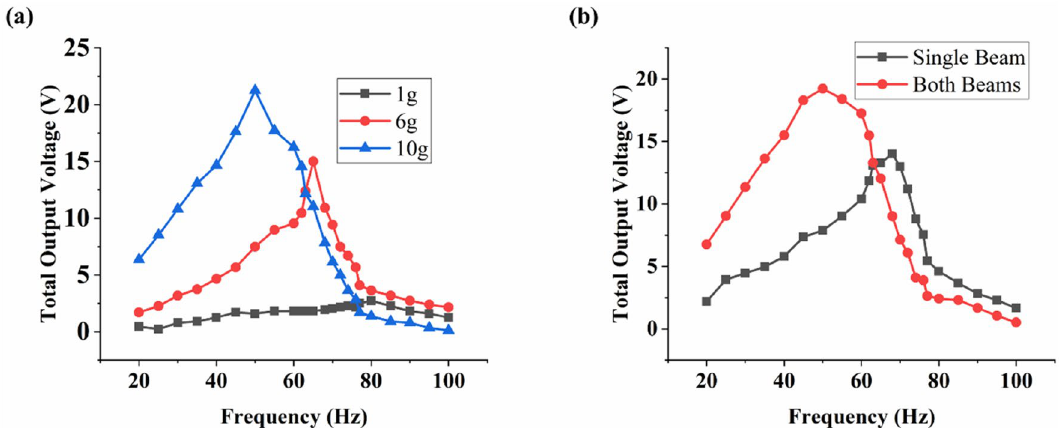
Figure 4. Total output voltage at ( a ) different masses (both beams), ( b ) different placement (10 g mass). Top piezoelectric beam open- circuit voltage Mass (g)